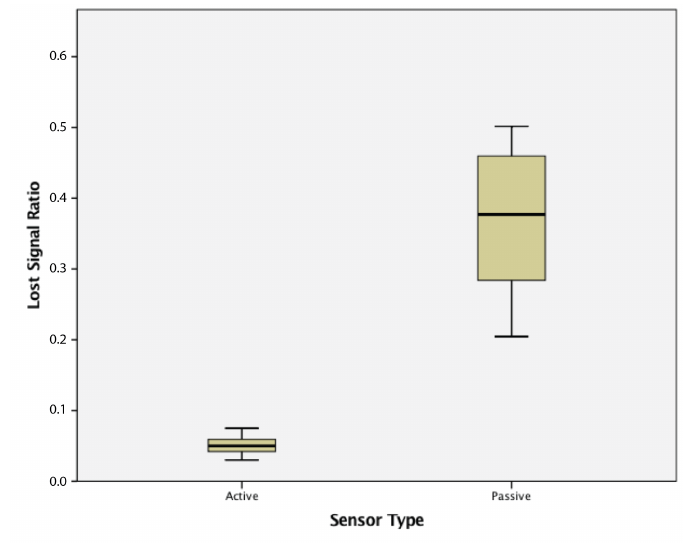
Figure 20. Lost signal ratio in a cluster of active vs. passive wireless sensor nodes.